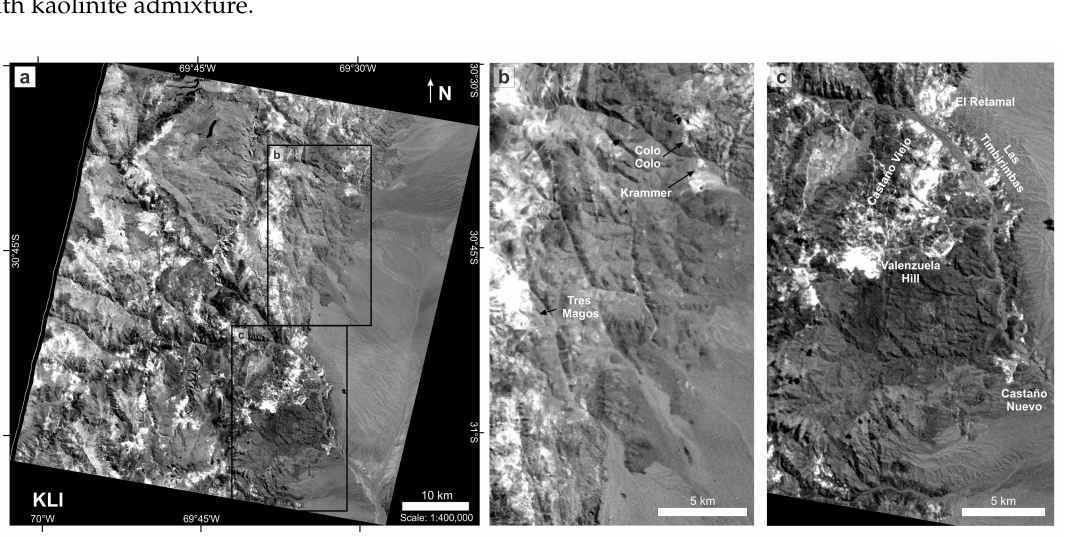
Figure 11. ( a ) Kaolinite index image (KLI), white zones represent areas where it is more likely to find kaolinite ( ± phyllosilicates). ( b ) The Tres Magos, Krammer and Colo-Colo alteration zones are highlighted white. ( c ) The NNE-trending Castaño Viejo alteration zone (from Valenzuela Hill to El Retamal and Las Timbirimbas) and the more restricted Castaño Nuevo alteration zone are identified in